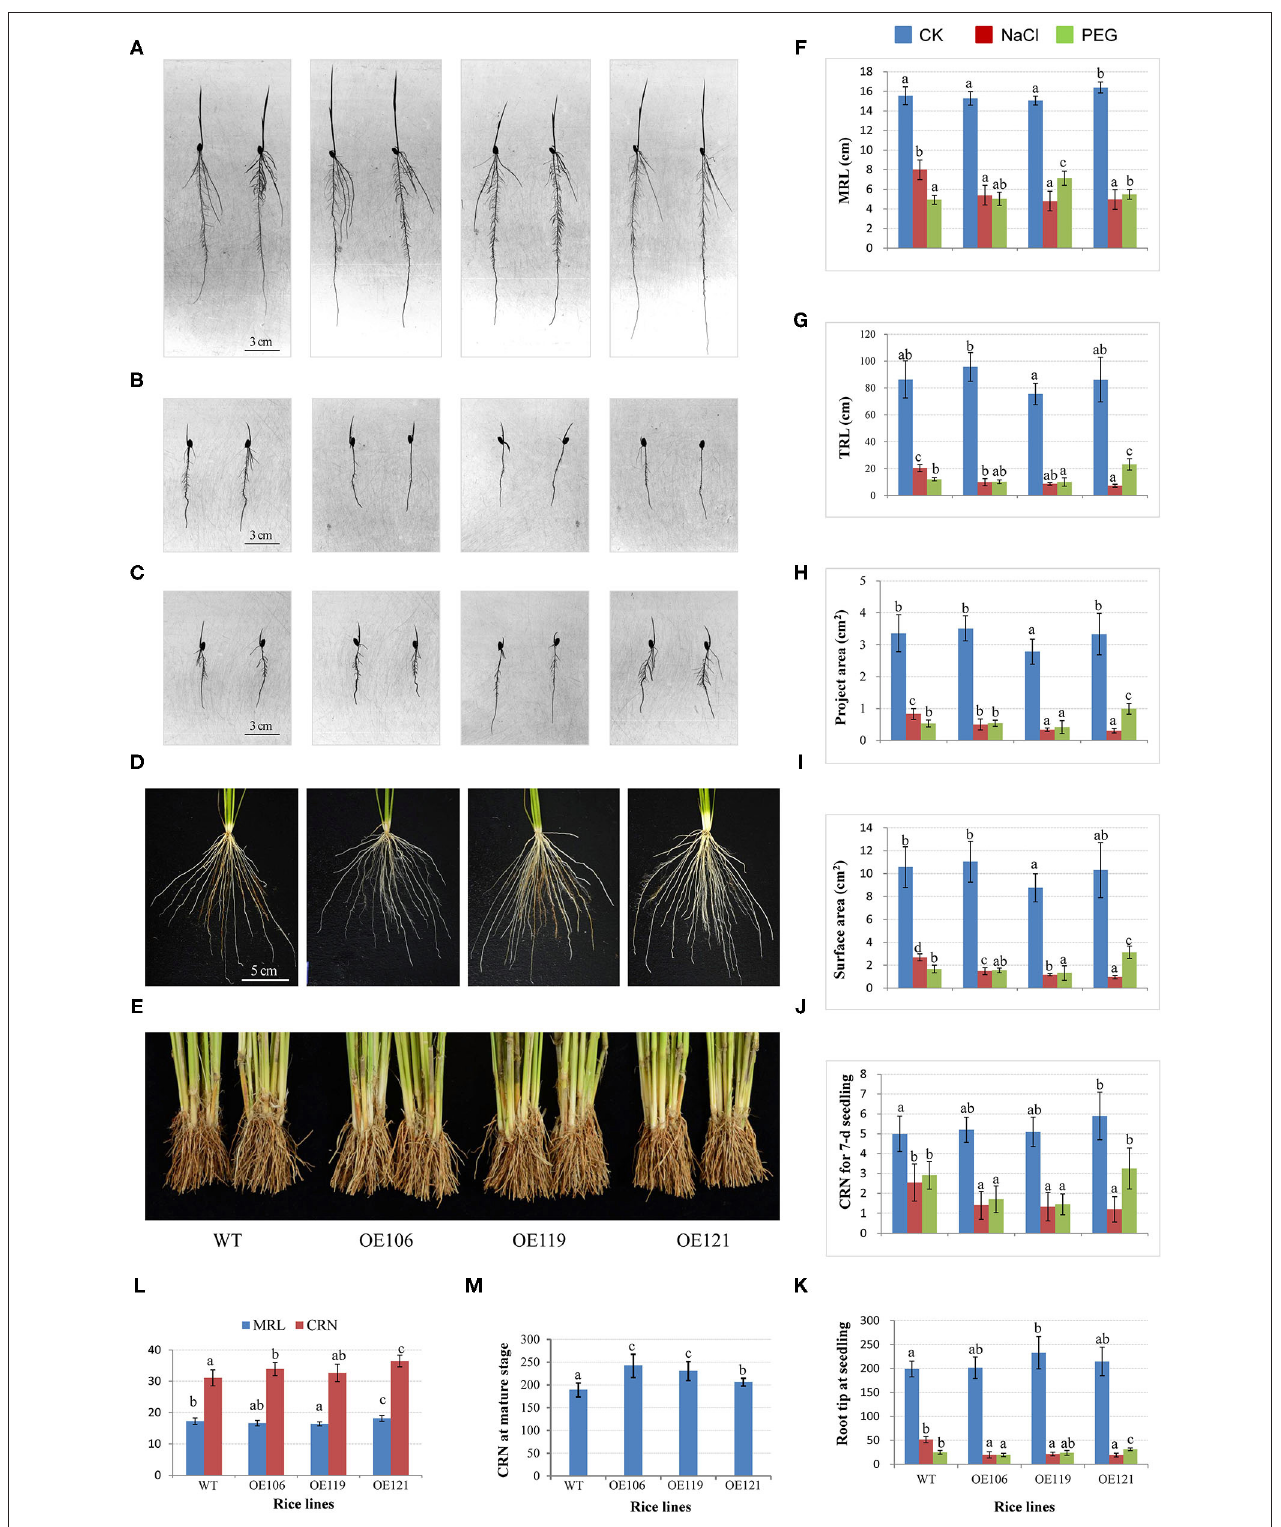
FIGURE 7 | Comparisons of root traits between TaWRKY51-overexpressing rice and the wild-type (WT) control at various developmental stages. The root images of 7-day-old seedlings cultured in pouches under normal (A) , NaCl (B) , and PEG (C) stressed conditions. The root images for 6-week-old seedlings (D) and mature plants (E) were cultured in the paddy soil. Comparisons of maximum root length (F) , total root length (G) , total project root area (H) , total surface area (I) , crown root number (CRN) (J) , and root tip number (RTN) (K) for rice seedlings grown in the root pouches (L) , comparisons of maximum root length and CRN for seedlings cultured in the paddy soil. (M) Comparison of CRN for mature plants grown in the paddy field.